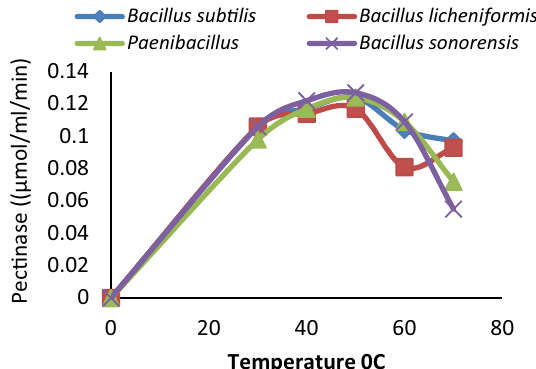
Figure 3. Effect of temperature on the activity of pectinase.